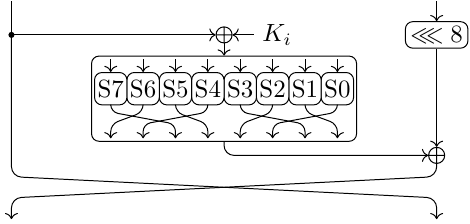
Figure 11: The round function of LBlock